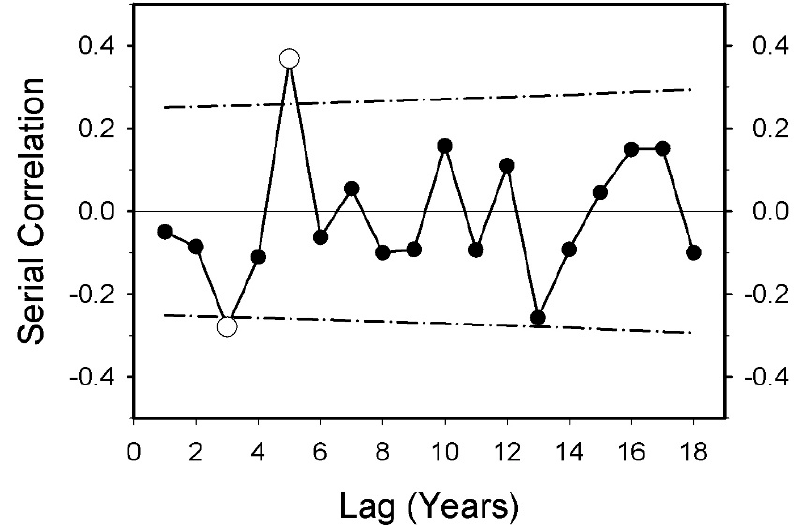
Figure 4. Autocorrelogram of annual precipitation inputs to Mweru basin. Upper and lower 95% confidence bound shown as dashed lines.